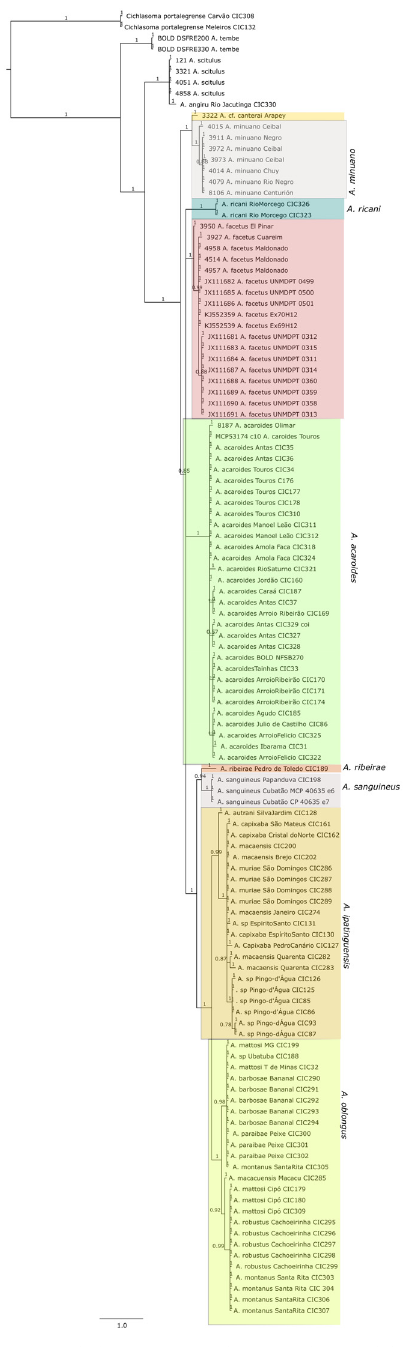
Fig 11. Phylogenetic tree of species of Australoheros based on Bayesian inference of sequences of mt-coI . Coloured rectangles and names to the right cover valid species; names of nominal species identified by locality contained within